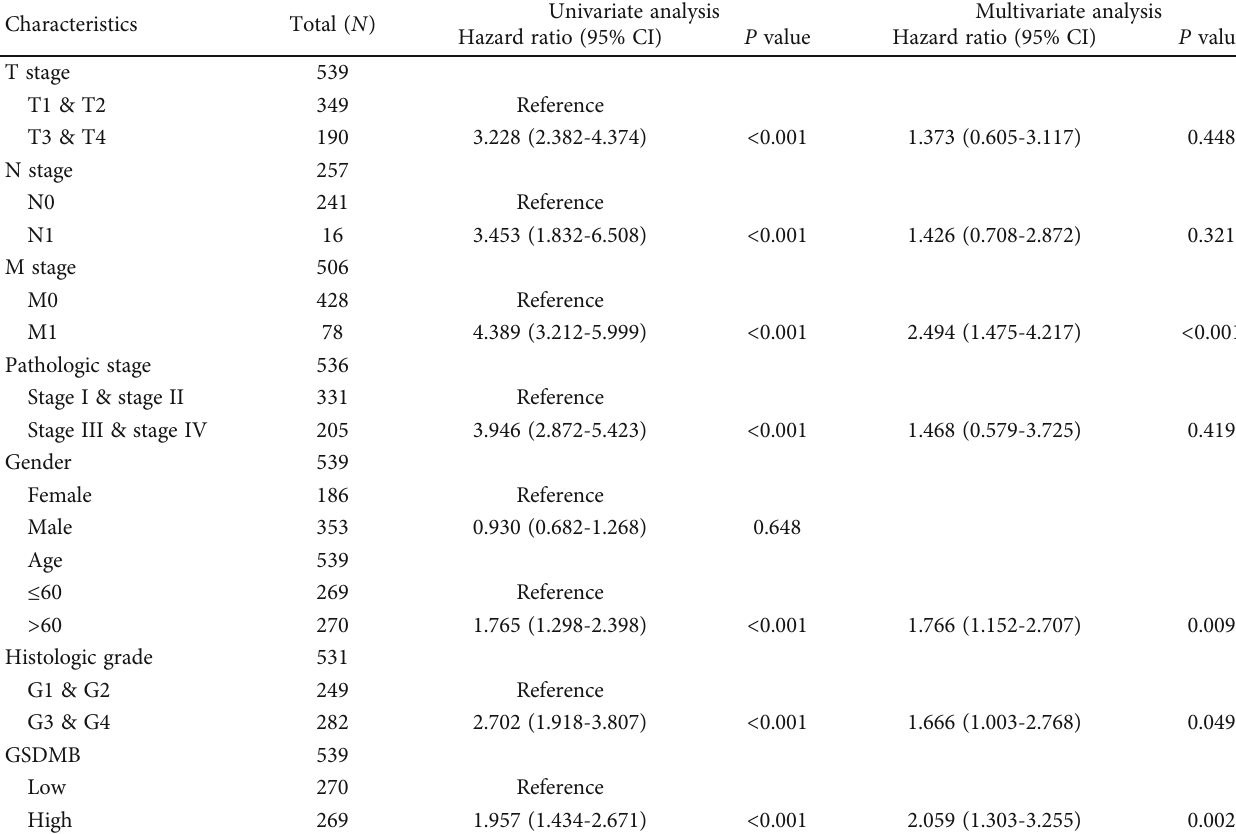
Table 2: Univariate and multivariate Cox proportional hazards analyses of MGSDMB expression and OS for patients with ccRCC.